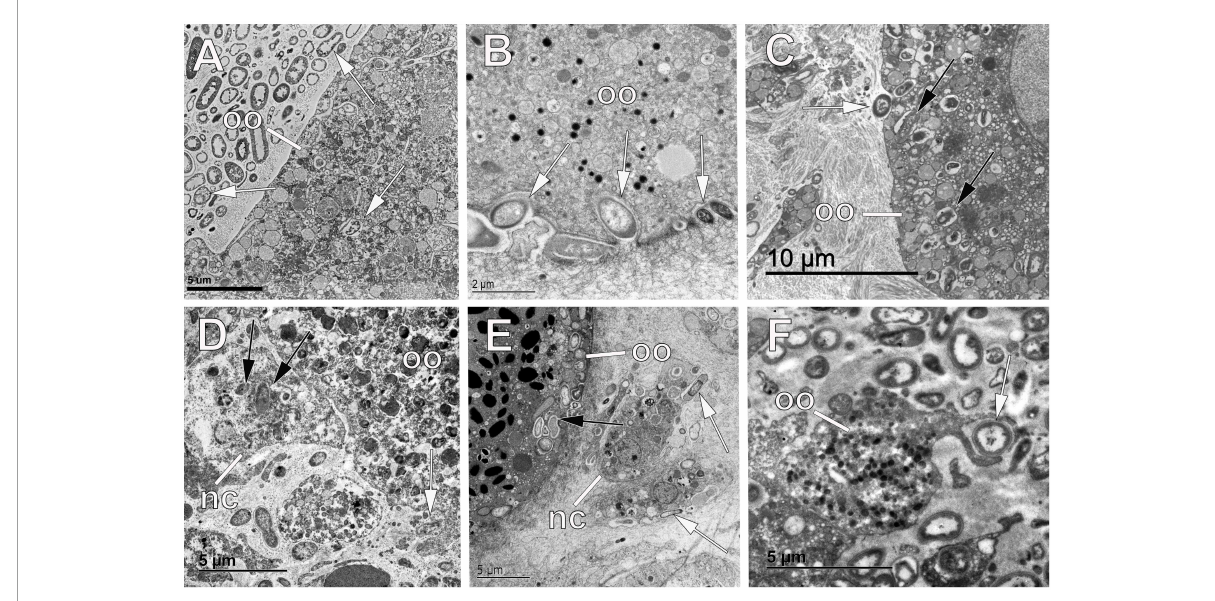
FIGURE4 Phagocytosis of symbionts by sponge oocytes. (A) Oocyte (oo) in the tetractinellid sponge Geodia barretti showing bacterial symbionts within vesicles (white arrows). (B) Oocyte (oo) of the homosclerophorid Corticium candelabrum showing phagocytotic processes of bacterial cells (white arrows). (C) Oocyte (oo) in the tetractinellid sponge G. barretti containing bacterial symbionts within vesicles (black arrows) and showing a depression of the oolemma for phagocytosis of a bacterial cell (white arrow). (D) Oocyte (oo) in the chondrosiid Chondrosia reniformis with a nurse cell (nc) in close proximity containing digested bacteria (black arrows) within its cytoplasm. Note the bacterial phagocytosis performed by the oocyte itself (white arrow). (E) Oocyte (oo) of the homosclerophorid C. candelabrum showing phagocytotic processes of bacterial cells (black arrows) and nurse cells (nc) dragging symbionts (white arrows) to the oocyte periphery. (F) Oocyte (oo) in the chondrosiid C. reniformis phagocytosing a symbiotic bacterium from the mesohyl (white